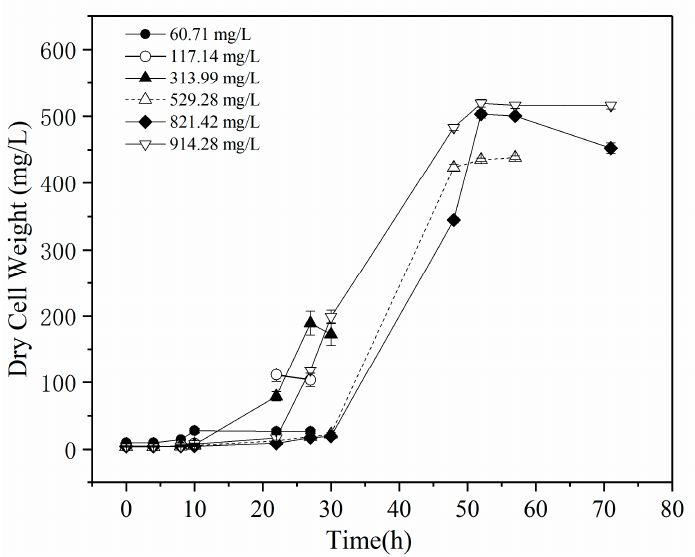
Figure 5. Increasing trend of biomass with ascending concentration of phenol from 60.0 to 914.28 mg/L.